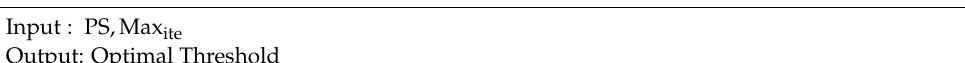
Algorithm 1 Pseudocode for